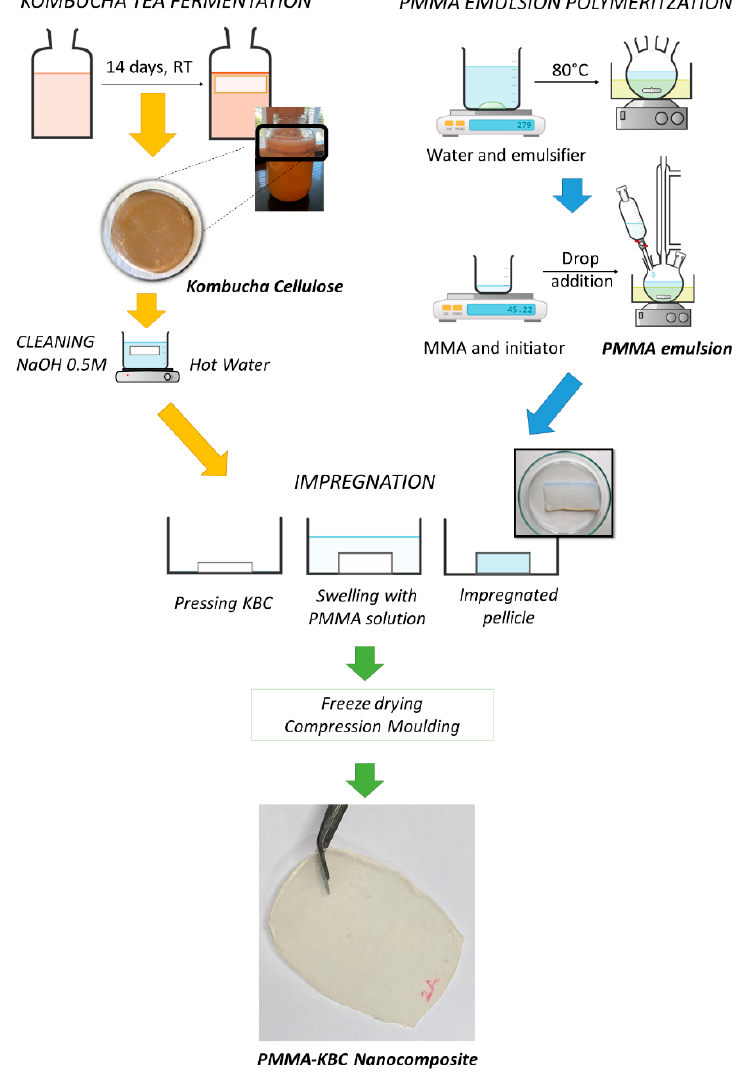
Figure 1. Schematic process of poly(methyl methacrylate)-kombucha bacterial cellulose (PMMA- KBC) nanocomposite production from kombucha tea fermentation and PMMA emulsion polymeriza- tion. MMA: methyl methacrylate; RT: room